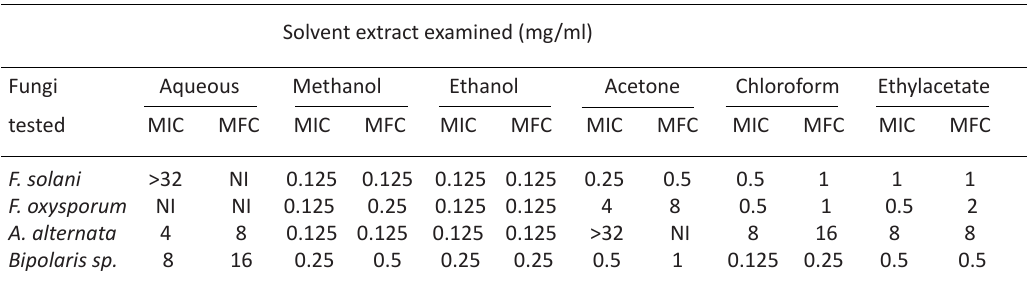
Table 4. Minimum Inhibitory and Minimum Fungicidal Concentration (MIC and MFC) of Laurus nobius extracts Solvent extract examined (mg/ml) Fungi Aqueous Methanol Ethanol Acetone Chloroform